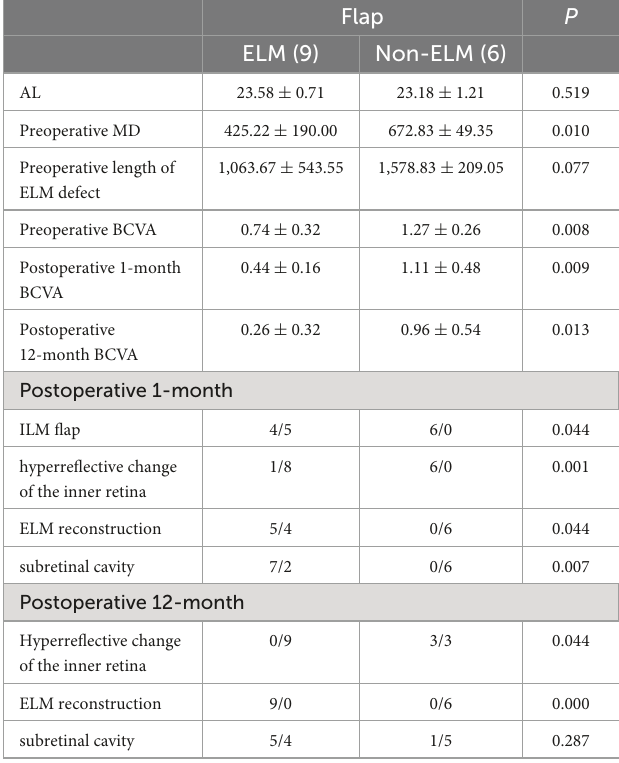
TABLE 4 Comparison of the preoperative and postoperative anatomical structures and visual function of the flap and peeling groups for MDs of ≤ 579 µ m*.